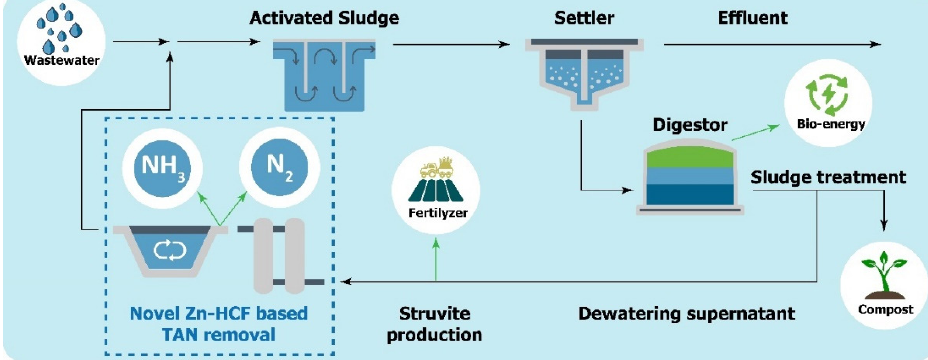
Figure 1. Scheme of the wastewater treatment process, showing the proposed process placement, with struvite production on the supernatant stream [35].